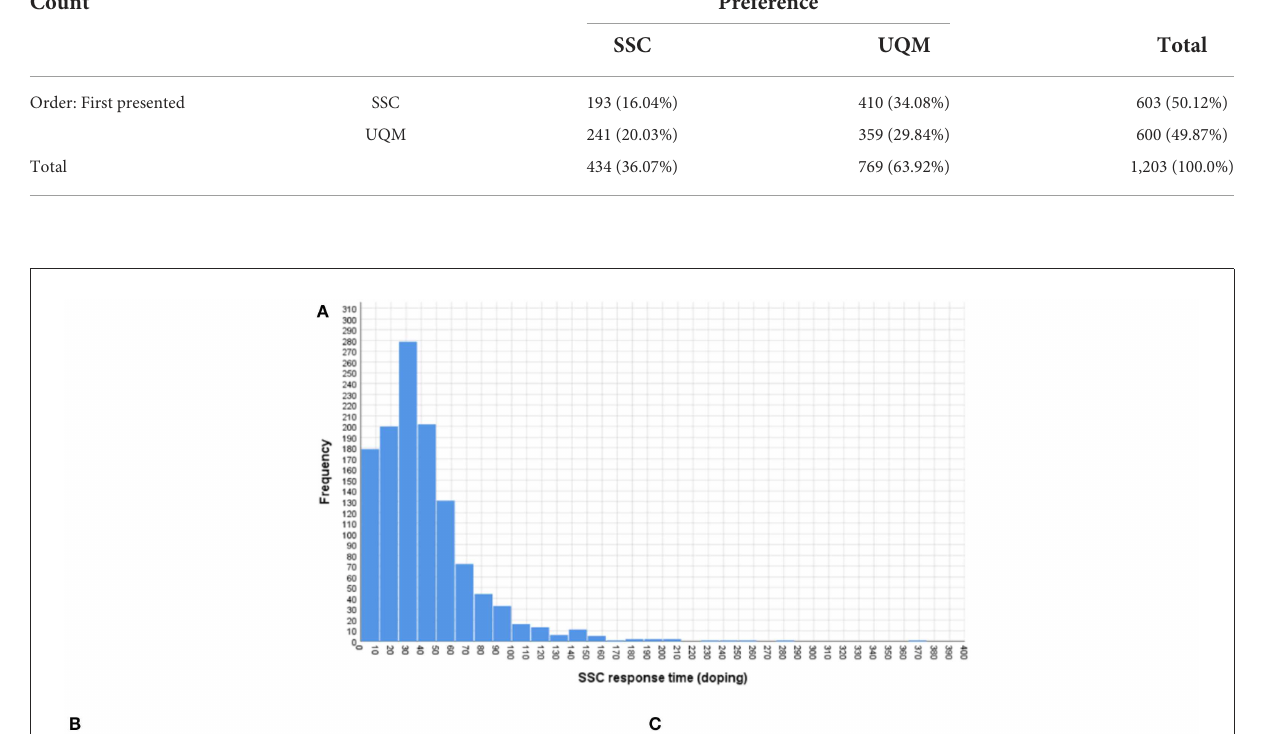
TABLE 8 Interaction between preference for and order of the estimation models.